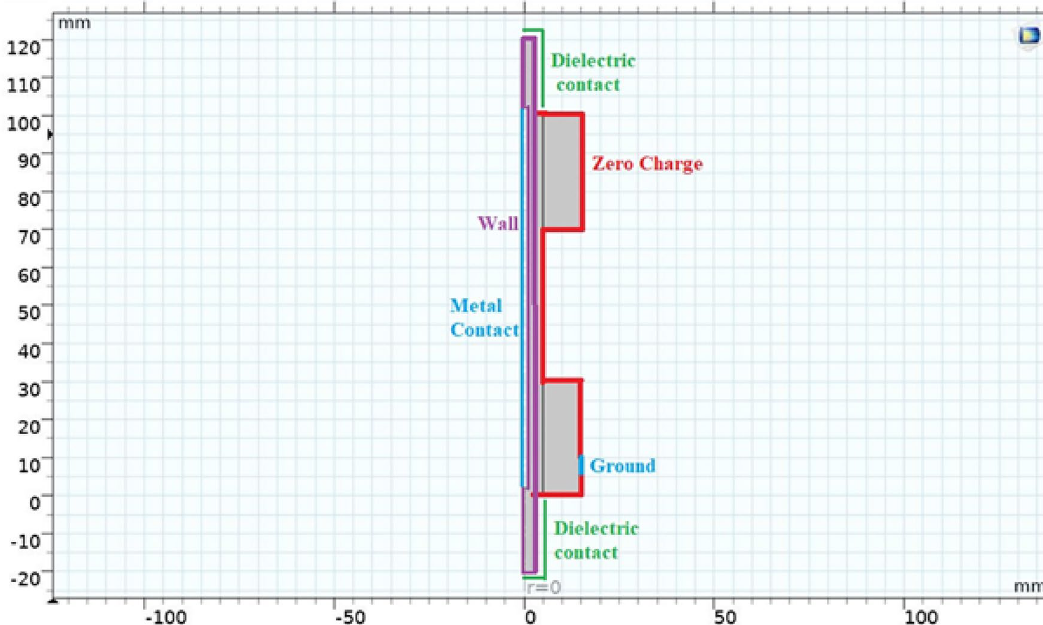
Figure 2. Model’s boundary